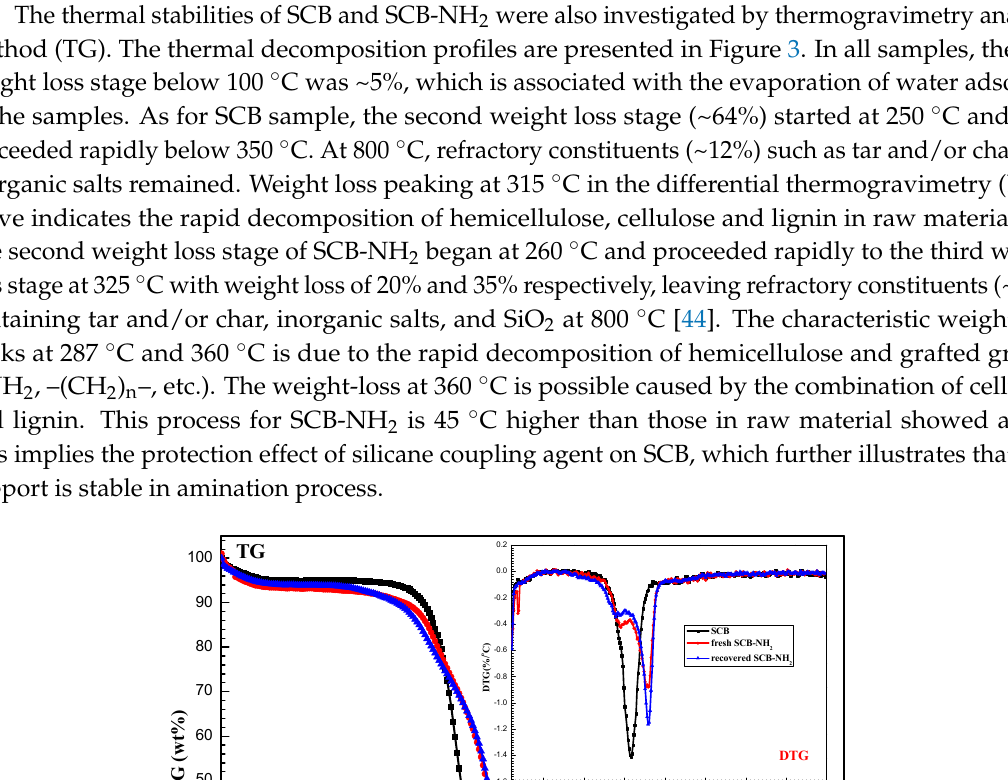
2 , and recovered SCB-NH 2